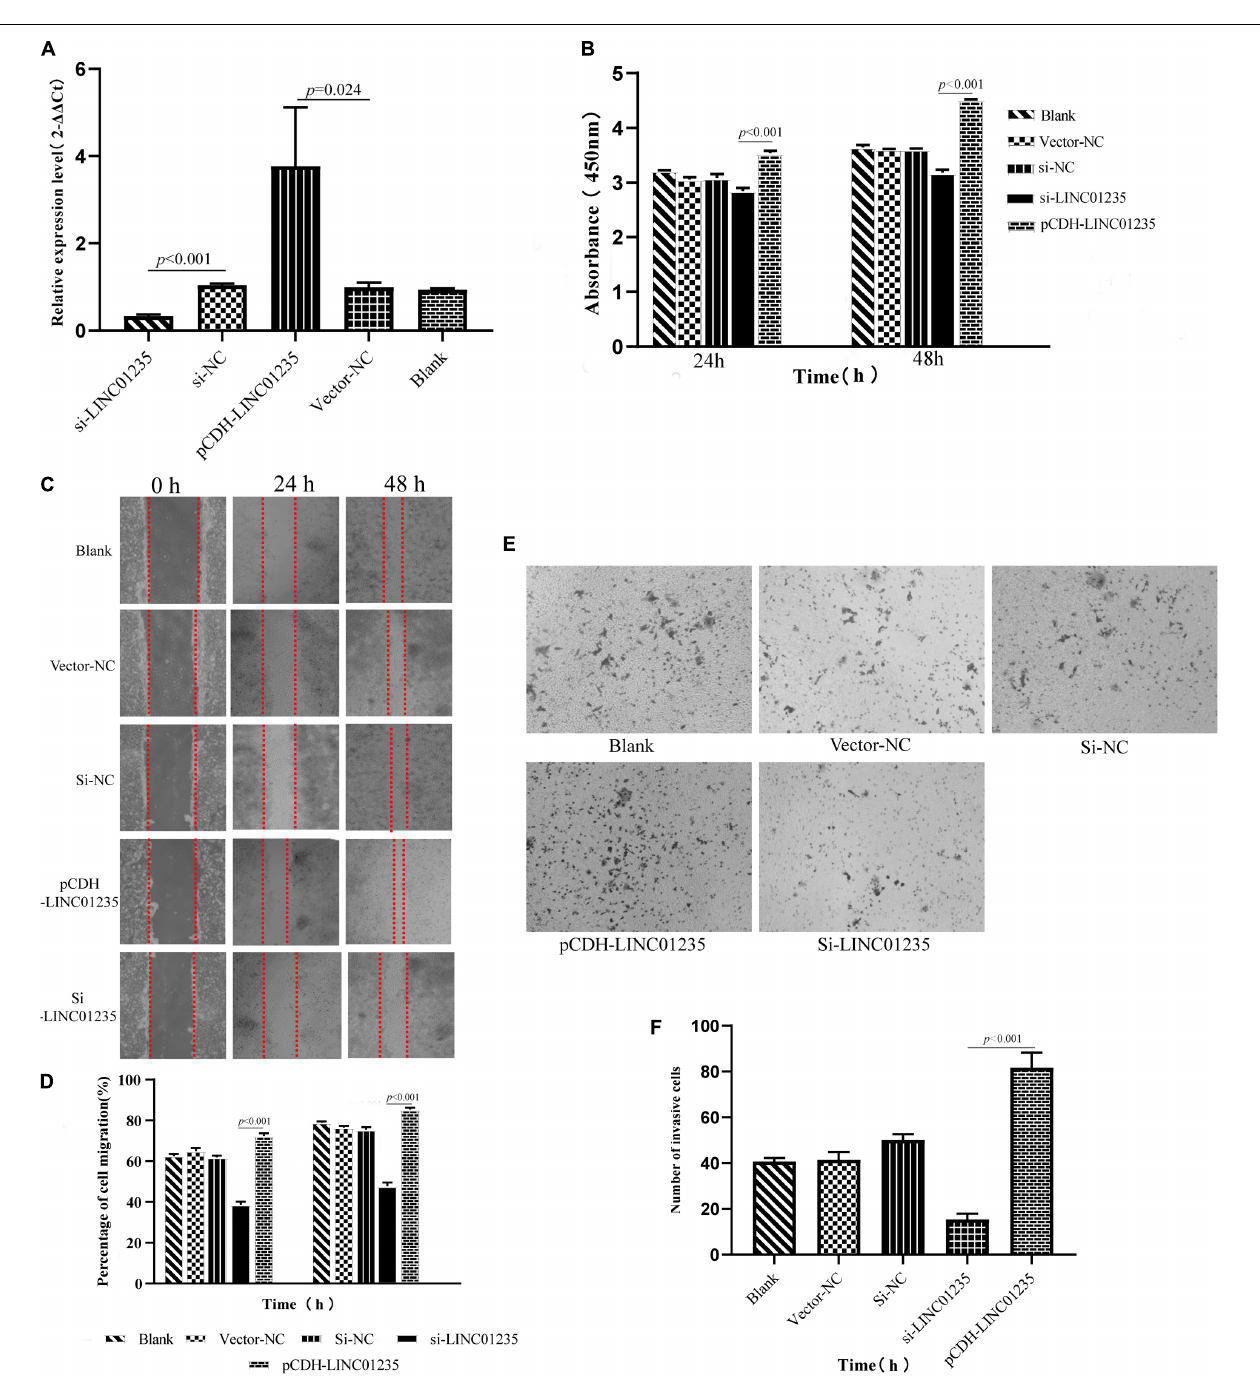
FIGURE 6 | (A) LINC01235 knockout and overexpressed efficiency in MCF-7 cells analyzed by qPCR. (B) The effects of LINC01235 knockout and overexpressed on the proliferation activity of MCF-7 cells measured using the CCK-8. (C,D) The effects of LINC01235 knockout and overexpressed on MCF-7 cell migration measured using wound-healing assay. (E,F) The effects of LINC01235 knockout and overexpressed on MCF-7 cell invasion using transwell assay.